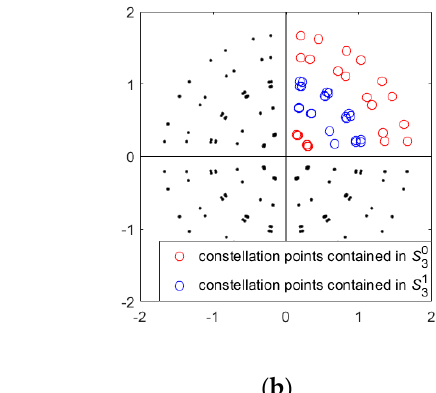
7 of 14 Figure 3. The subsets of ED comparison to calculate LLR( 𝑏 (cid:2874) ) when the received symbol is in the first